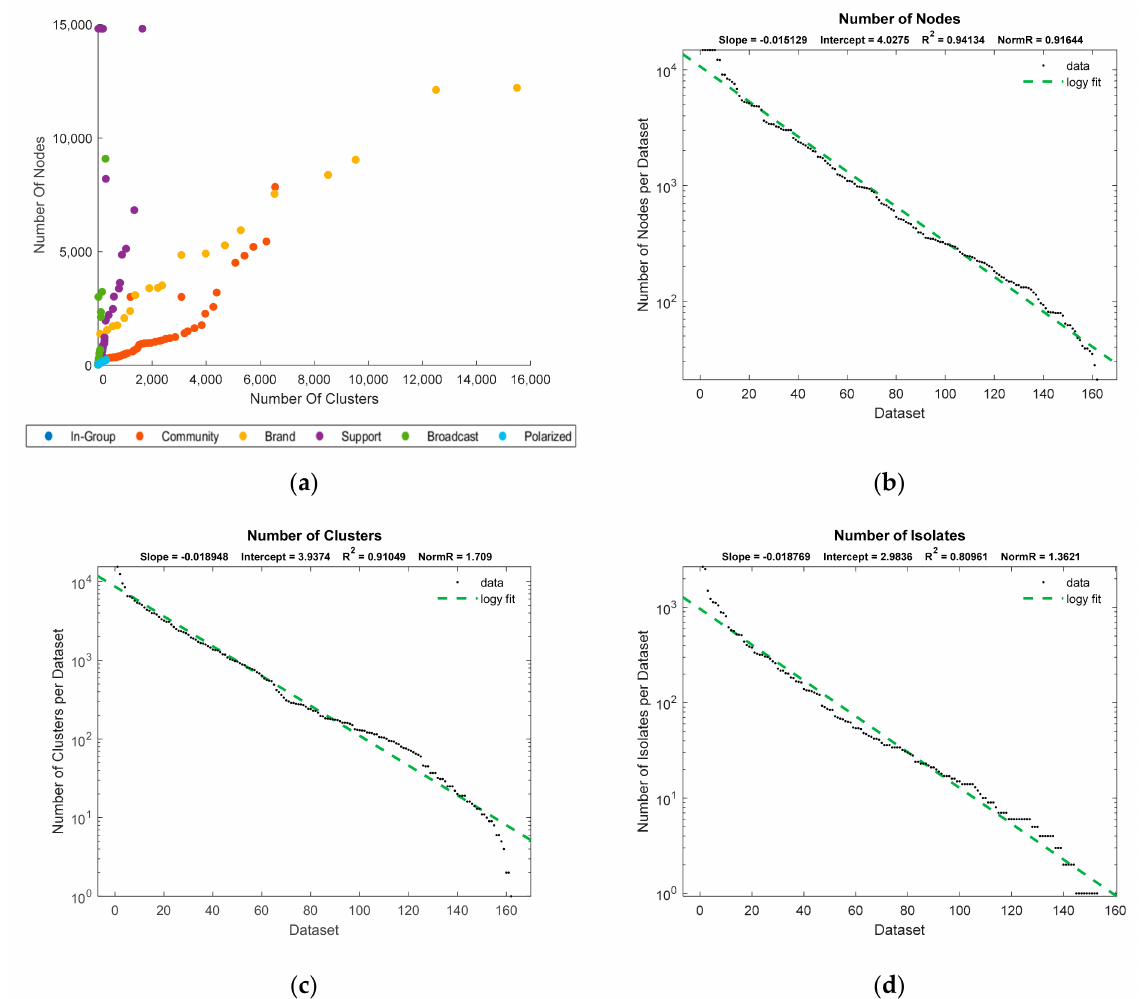
Figure 7. Dataset metrics and distributions. ( a ) shows the distribution of nodes and clusters within datasets used; colors show different topic-based topologies. The diversity of datasets can be seen by observing their log values for ( b ) number of nodes, ( c ) clusters, and ( d ) isolates. Each graph is sorted for easier observation and has details above showing R 2 and the norm of residuals. Note that datasets have identical values if data points are equal according to the y-axis, for example, in subgraph ( d